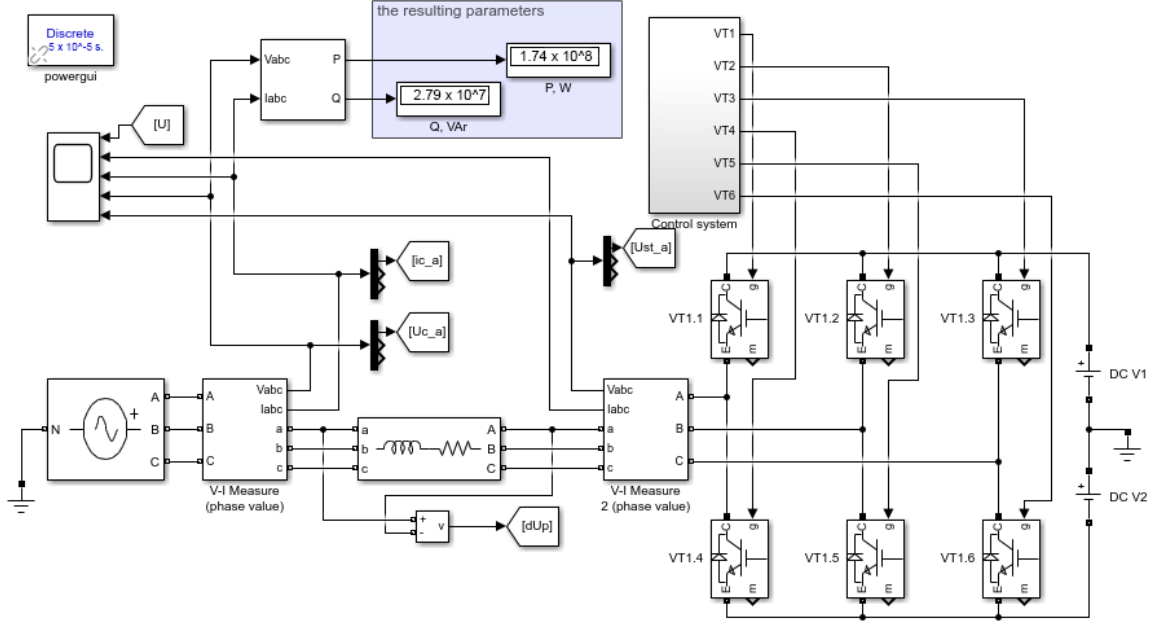
Figure 5. STATCOM power diagram.